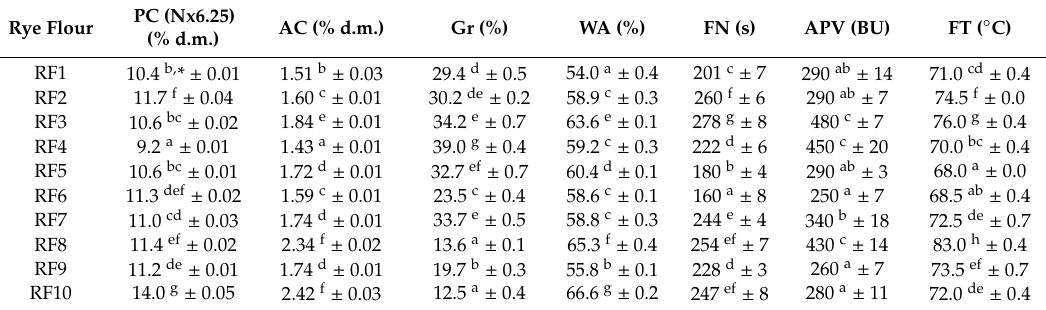
Table 1. The basic quality parameters of tested rye